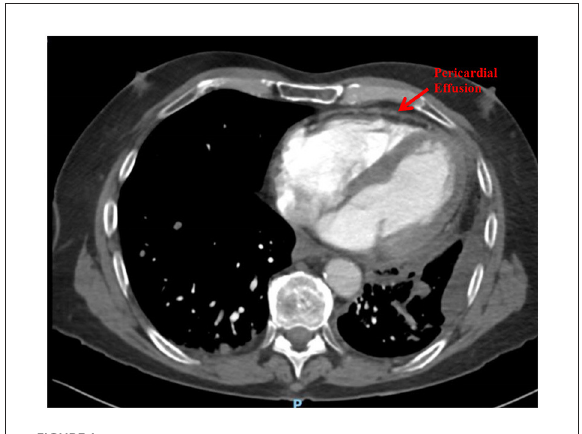
FIGURE1 Pericardial effusion after 12 cycles of Nivolumab (Case 1).